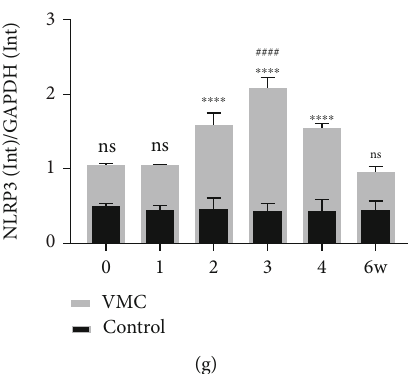
Figure 2: The change pattern of NLRP3-related molecules in myocardial tissue in VMC process. (a) Relative mRNA expression of NLRP3, Caspase-1, ROR γ t, IL-1 β , IL-17, and IL-18 in heart tissues in CVB3-induced VMC. (b) IL-17 expression in heart tissue detected by IHC (original magni fi cation × 400). (c) IL-17 expression in heart tissue acquired by IHC assay, and IOD value was calculated by Image-Pro Plus. (d, e) The protein expression of ROR γ t in heart tissue was detected by WB and calculated by Bio-Rad Image Lab 6.0. (f, g) The protein expression of NLRP3 in heart tissue was detected by WB and calculated by Bio-Rad Image Lab 6.0. Statistical description: ns, ∗ , ∗ ∗ , ∗∗∗ , and ∗∗∗∗ stand for no statistically signi fi cant di ff erence, P < 0 : 05 , P < 0 : 01 , P < 0 : 001 , and P < 0 : 0001 , respectively, for VMC group versus control group at di ff erent time points. ## and ### mean P < 0 : 001 for the marked VMC group versus other VMC